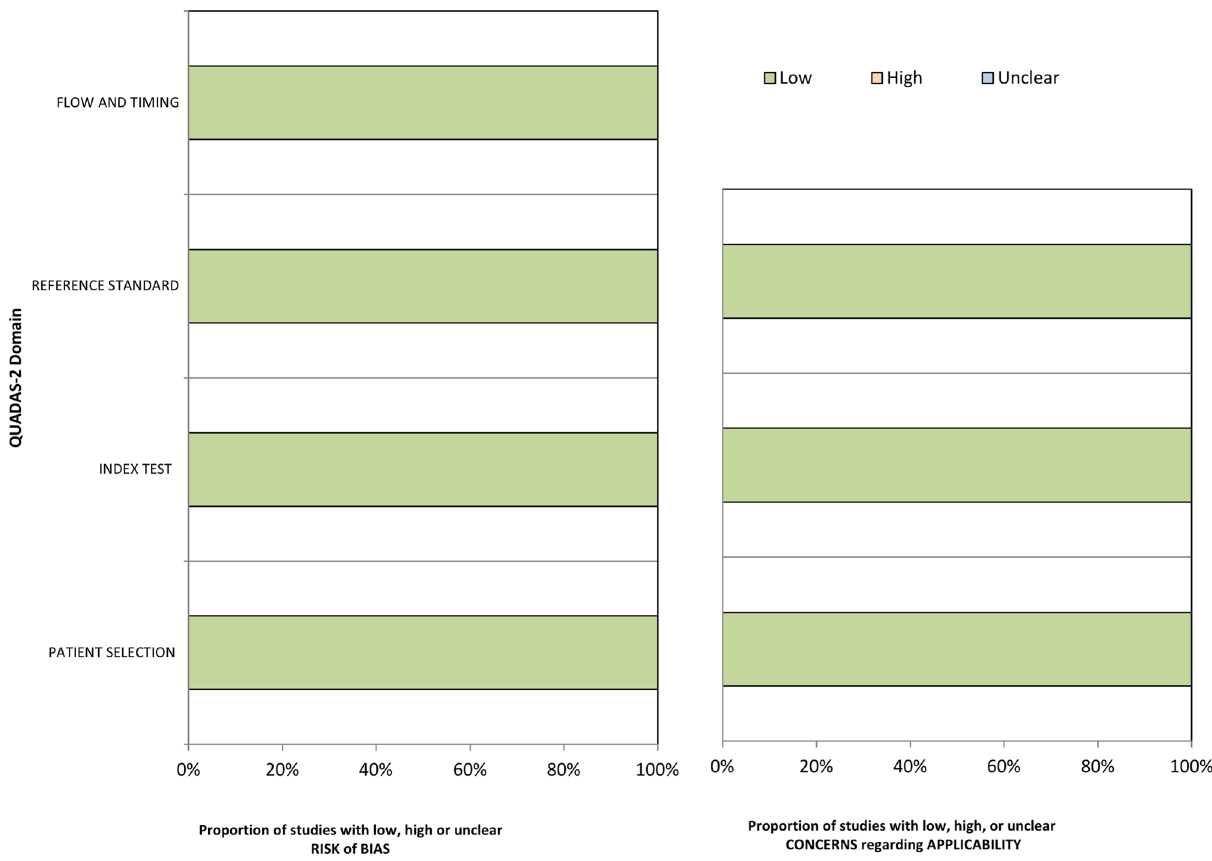
Figure 1. Assessment of risk of bias and concerns regarding applicability of the included studies using the Quality Assessment of Diagnostic Accuracy Studies Tool